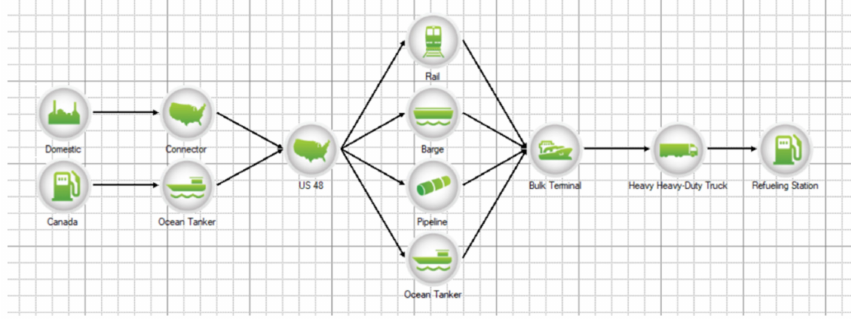
Figure 6. Shipping supply chain for diesel from production to